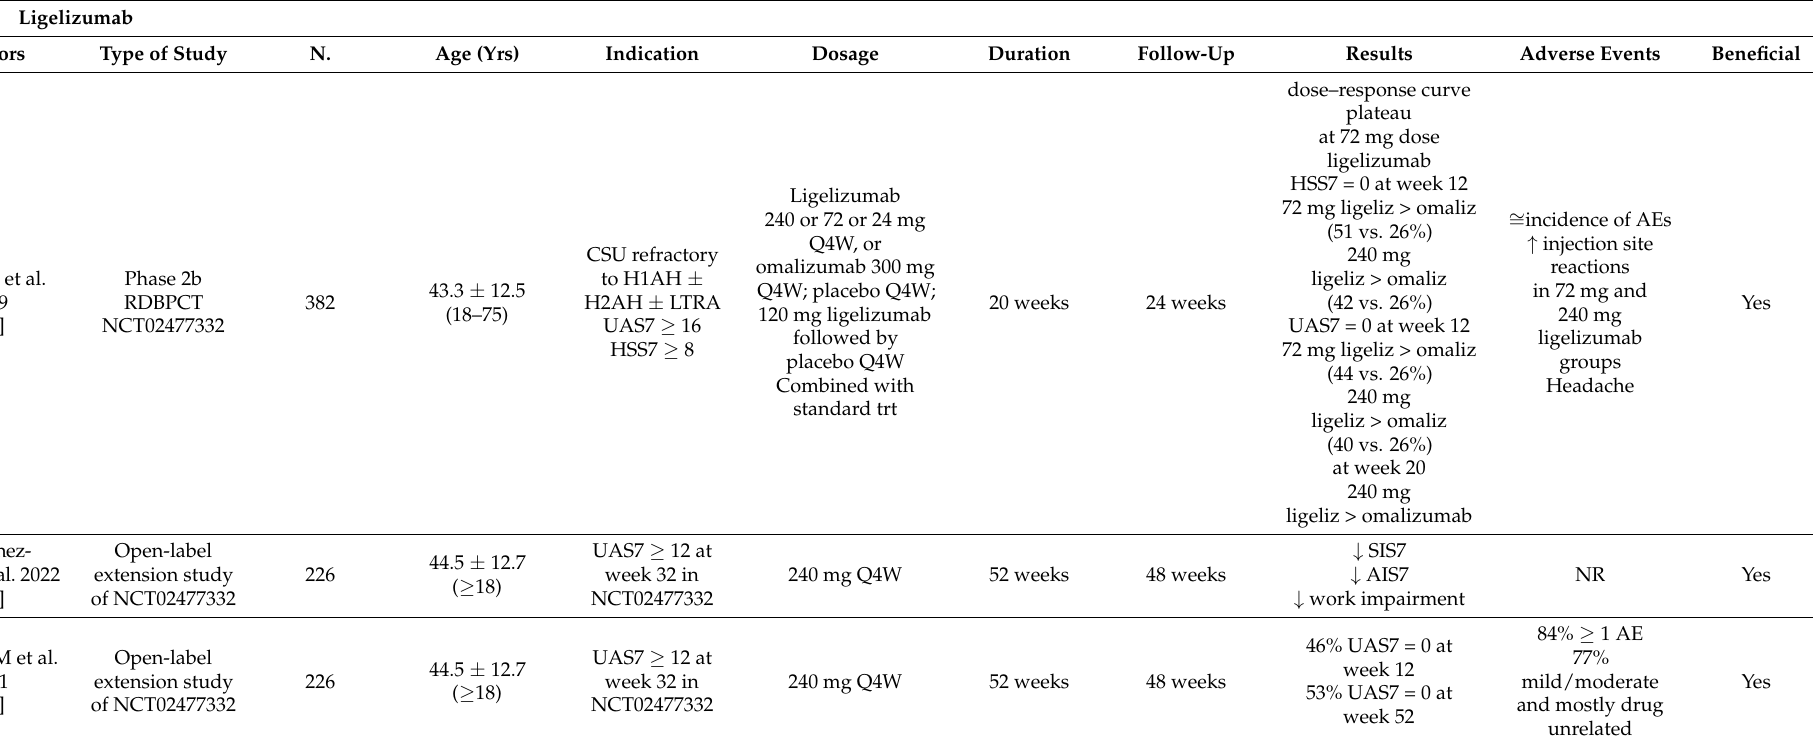
Table 2. List of the studies investigating other mAbs in treating